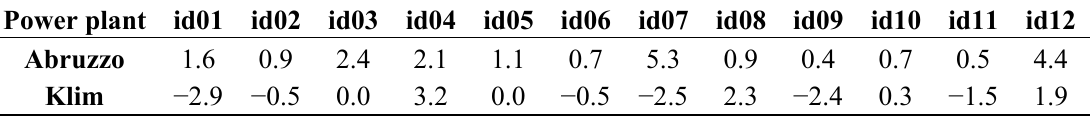
Table 4. Model bias for Abruzzo and Klim. Bias is expressed as percentage of NP. Power